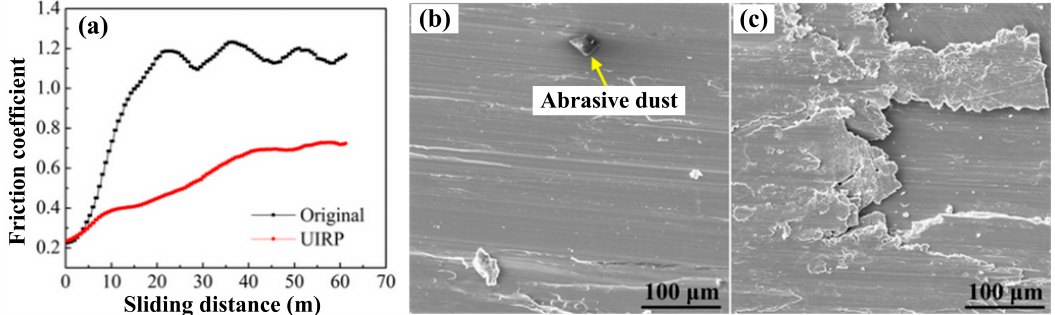
Figure 9. Friction coefficients and worn morphologies obtained at 478 r/min after 300 cycles. ( a ) Friction coefficients; ( b ) worn morphology of UIRP sample; ( c ) worn morphology of original sample.